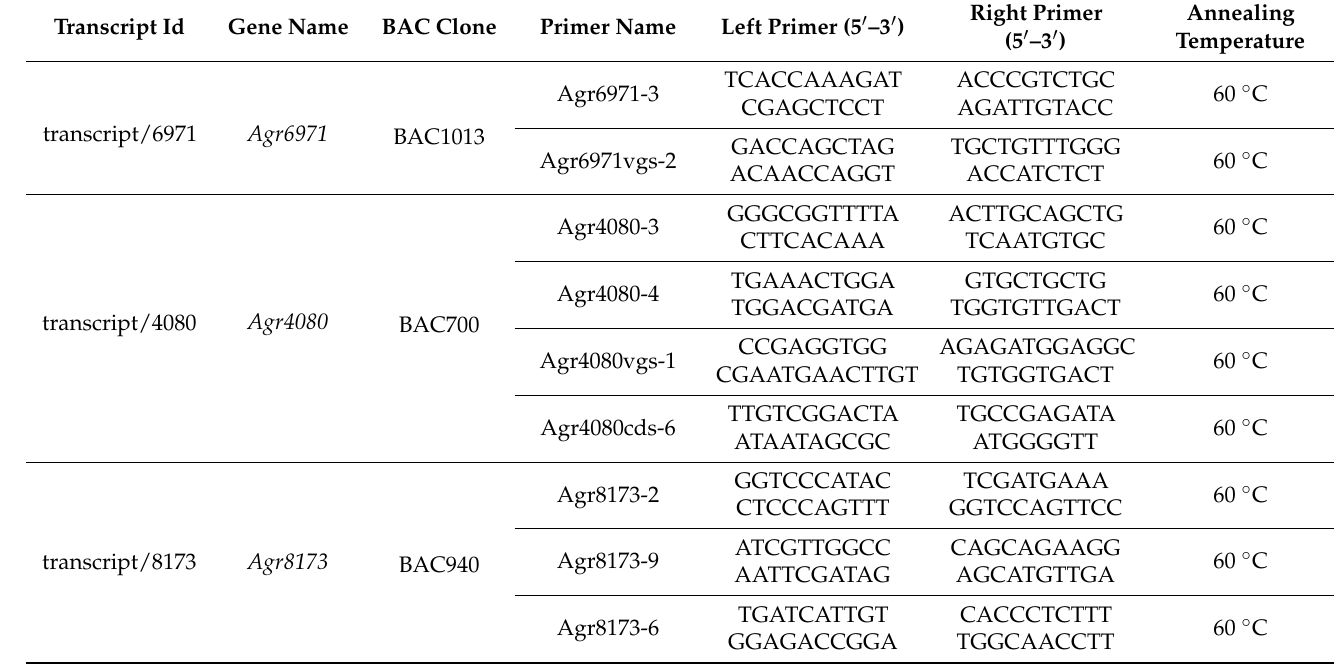
Table 1. Sequences of molecular markers designed according to A . cristatum transcript sequences.